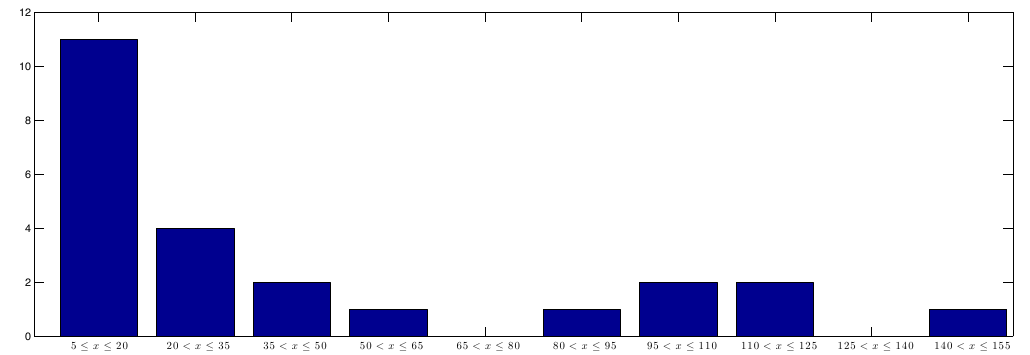
Figure 14. Distribution of the social cost of carbon ( x ), according to the studies discussed